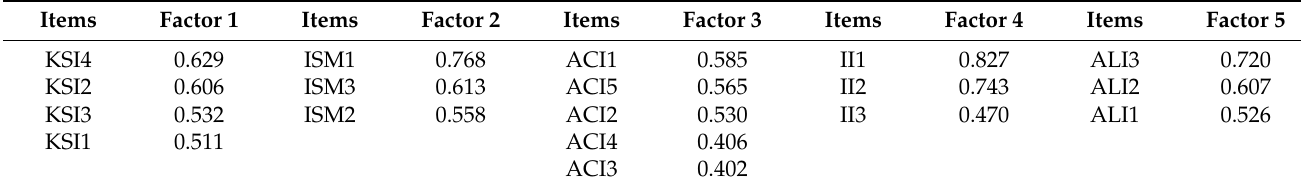
Table 6. Summary of the results from the CFA on the18 JIL Scale items for Sample 3b ( n = 549).